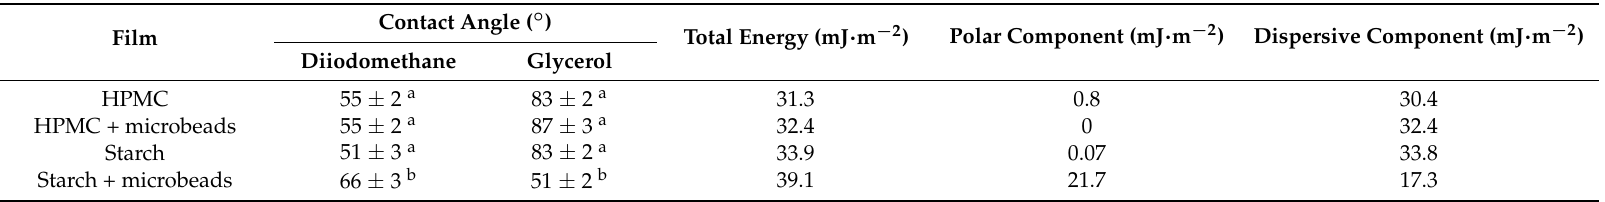
Table 2. Contact angle and surface energy of biopolymer films equilibrated at 5 ◦ C and 75% relative humidity. Mean values and standard deviation.